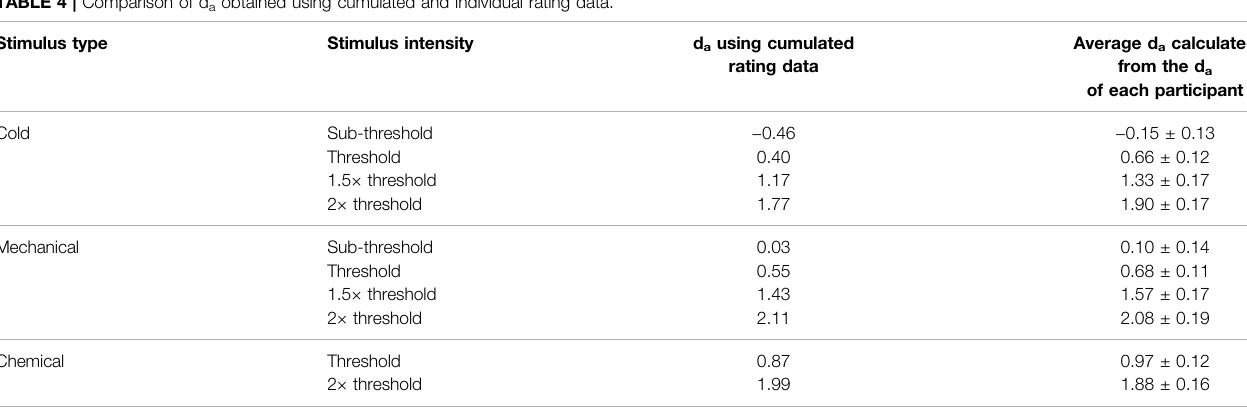
TABLE 4 | Comparison of d a obtained using cumulated and individual rating